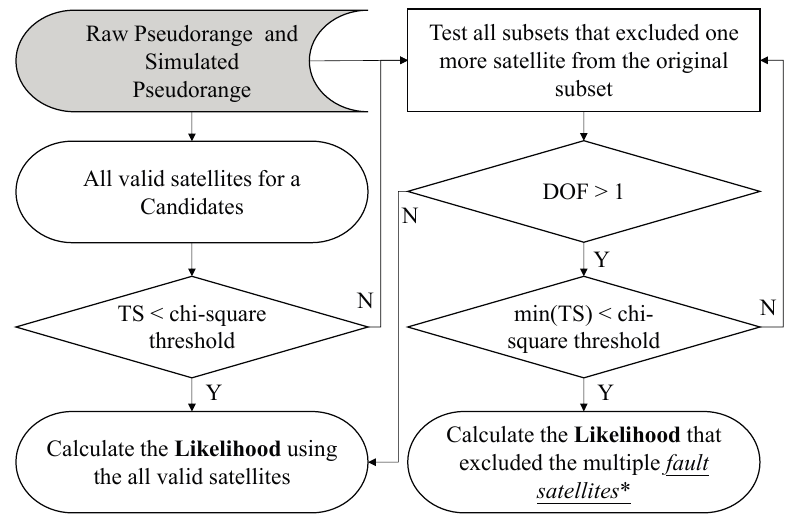
Figure 5. RAIM multiple fault exclusion used in the proposed 3D map method. TS, test statistic; and DOF, degree of